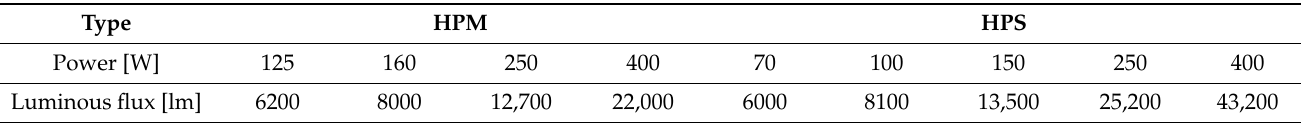
Table 1. Basic properties of existing street lighting sources.